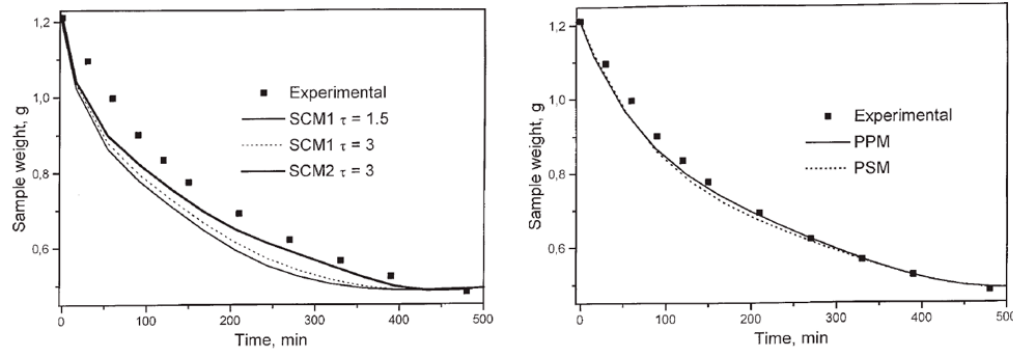
Figure 14. Comparison of experimental data with model results (SCM: shrinking core model; PPM: parallel pore model; PSM: pore in series model). Adopted with permission from [86].